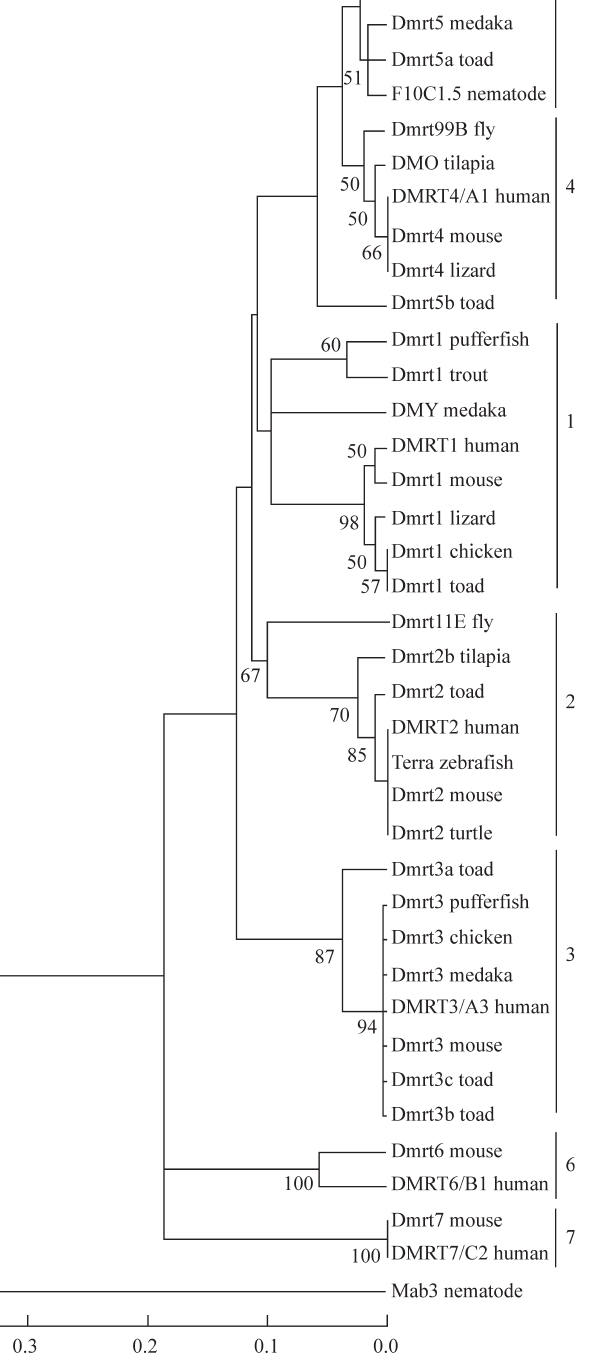
Figure 3 - Neighbor-joining phylogenetic tree (1000 replicates) of some vertebrate and invertebrate doublesex/male abnormal 3 (dsx/mab-3 or DM) related transcription factor ( DMRT ) gene family members based on aminoacidsequencedata.NematodeMab-3sequencesweretheoutgroup. Branches with less than 50% support have been collapsed. The toad DM domain sequences in the tree were the Bufo gargarizans sequences ob- tained during the research described in this